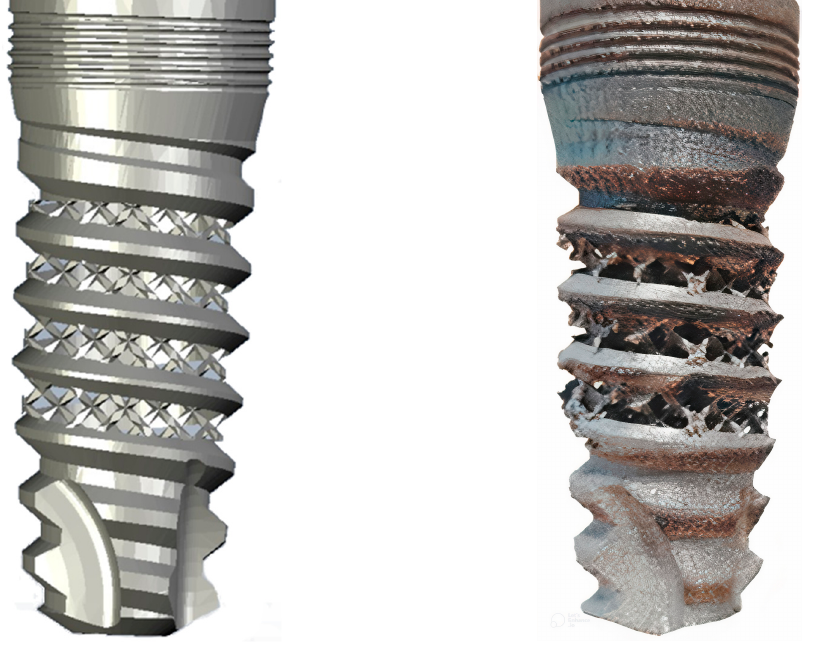
Figure 6. Implant body manufactured by additive 3D printing before machining its internal thread. Left side image, computer recreation. Right side the 3D printed